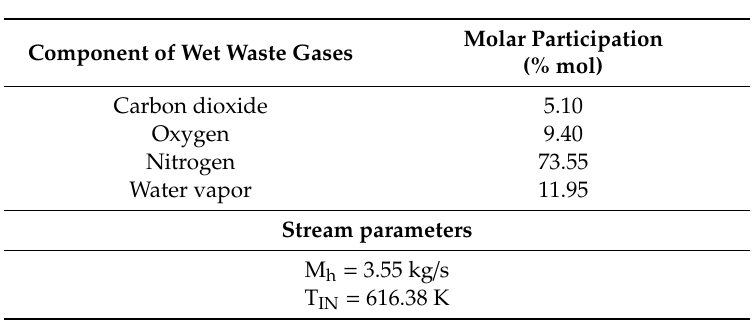
Table 1. Exhaust gases average properties